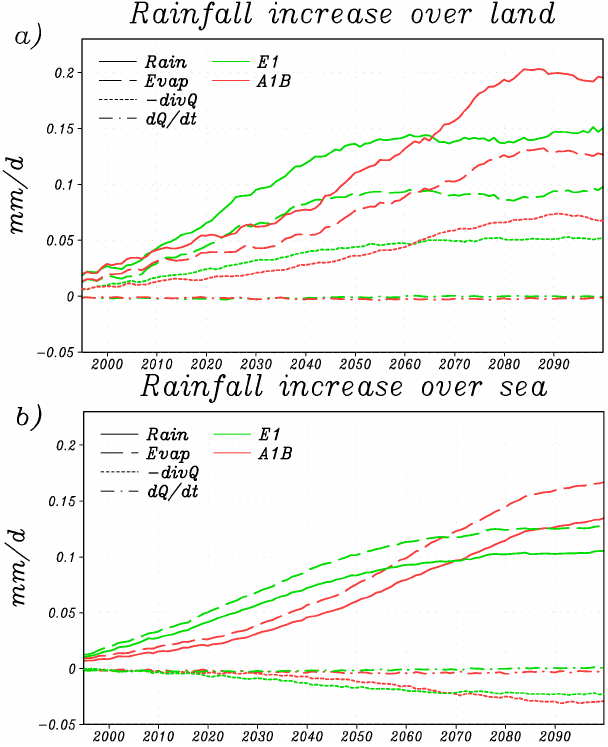
Fig. 7. Time evolution of 15-yr running means for (a) land averaged and (b) sea averaged contribution to rainfall change (solid lines) coming from local evapotranspiration (dashed lines), moisture con- vergence (dotted), and change in atmospheric total water content (dash-dot lines). A1B in red and E1 Fig. 6. Time evolution of 15-yr running means for land averaged (solid lines) and sea averaged (dashed lines) change of (a) precip- itation (mmd − 1 ) and (b) near surface temperature (K) relative to Fig. 7. Time evolution of 15-years running means for (a) land averaged and (b) sea averaged contribution to 1970–2000 climatology. (c) The Br evolution with inner axis de- rainfall change(solid lines) coming from local evapotranspiration (dashed lines), moisture convergence (dotted), noting land and the outer axis denoting ocean. A1B in red and E1 Fig. 6. Time evolution of 15-years running means for land averaged (solid lines) and sea averaged (dashed lines) green. Fig. 7. Time evolution of 15-years running means for (a) land averaged and (b) sea averaged contribution to and change in atmospheric total water content (dash-dot lines). A1B in red and E1 green. change of (a) precipitation(mm/d) and (b) near surface temperature(K) relative to 1970-2000 climatology. (c) rainfall change(solid lines) coming from local evapotranspiration (dashed lines), moisture convergence (dotted), The Br evolution with inner axis denoting land and the outer axis denoting ocean. A1B in red and E1 green. and change in atmospheric total water content (dash-dot lines). A1B in red and E1 green.